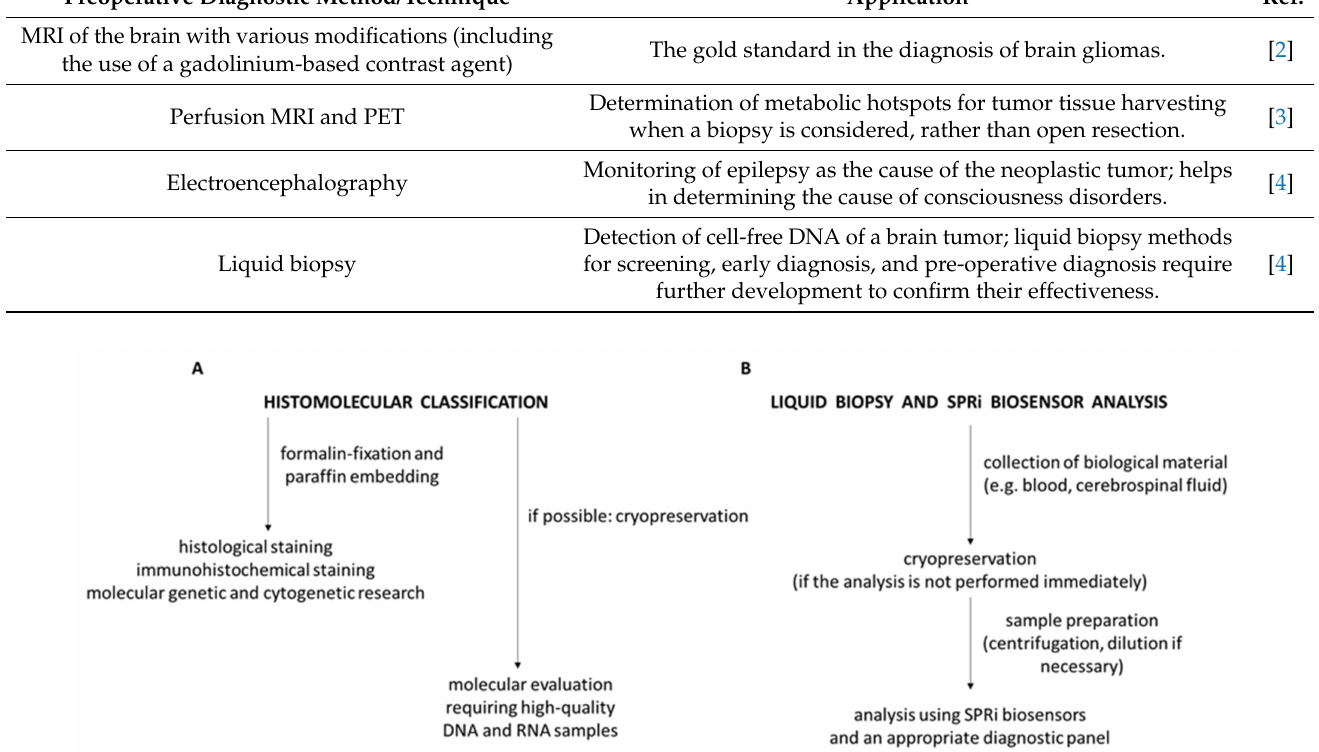
Figure 1. Scheme of procedure for histomolecular classification ( A ) and liquid biopsy ( B ). Diagram based on